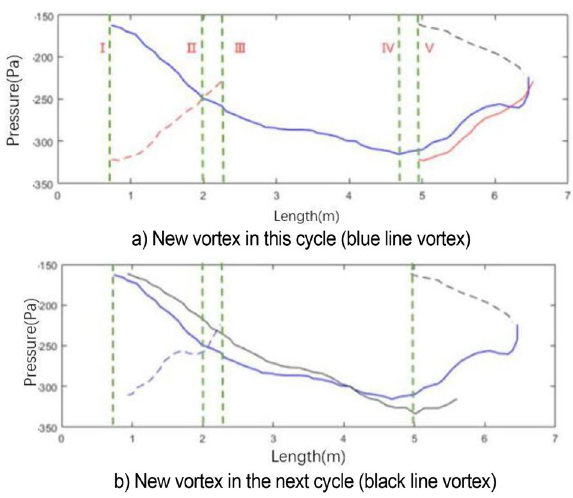
Figure 16. Development process of